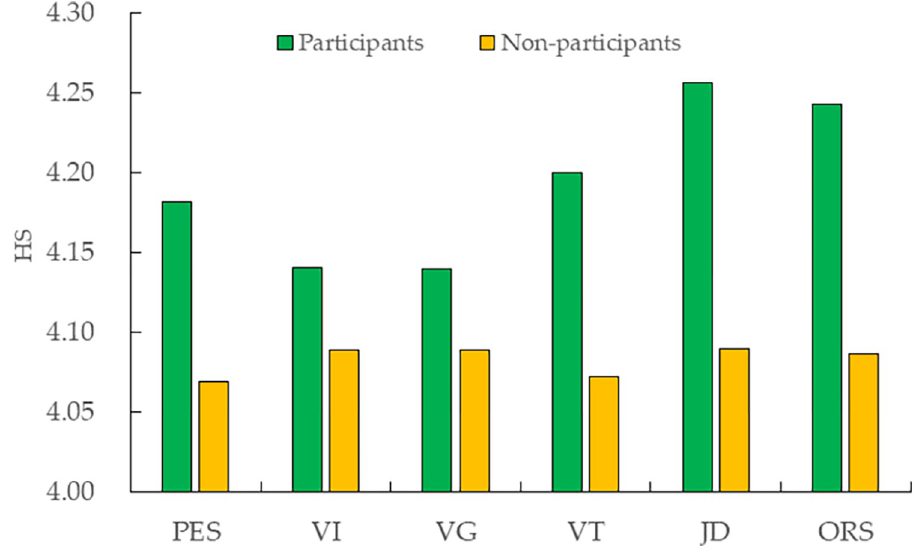
Fig 1. Differences in HS between participants and non-participants. Data is from the National Bureau of Statistics.